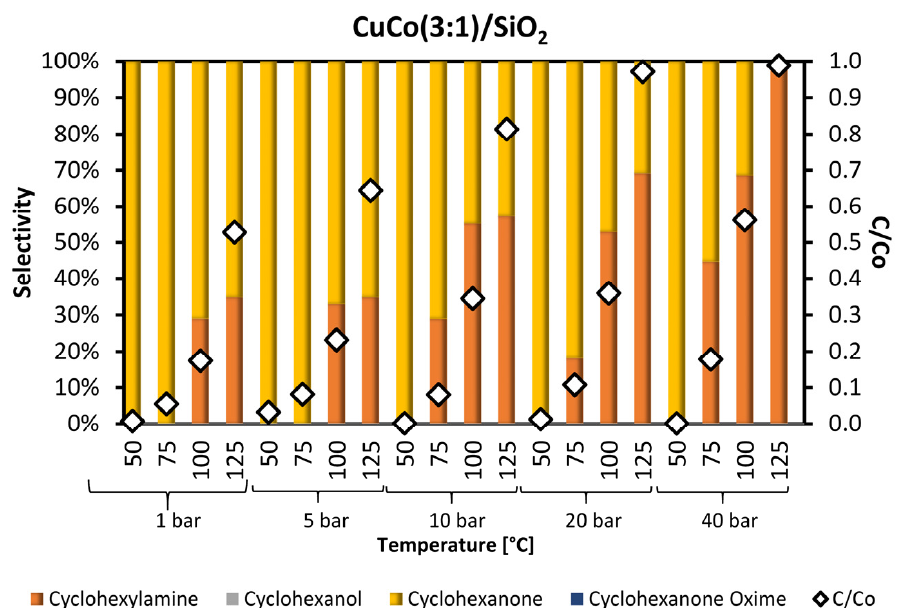
Figure 9. Catalytic hydrogenation of nitrocyclohexane in liquid flow conditions with CuCo(3:1)/SiO 2 .